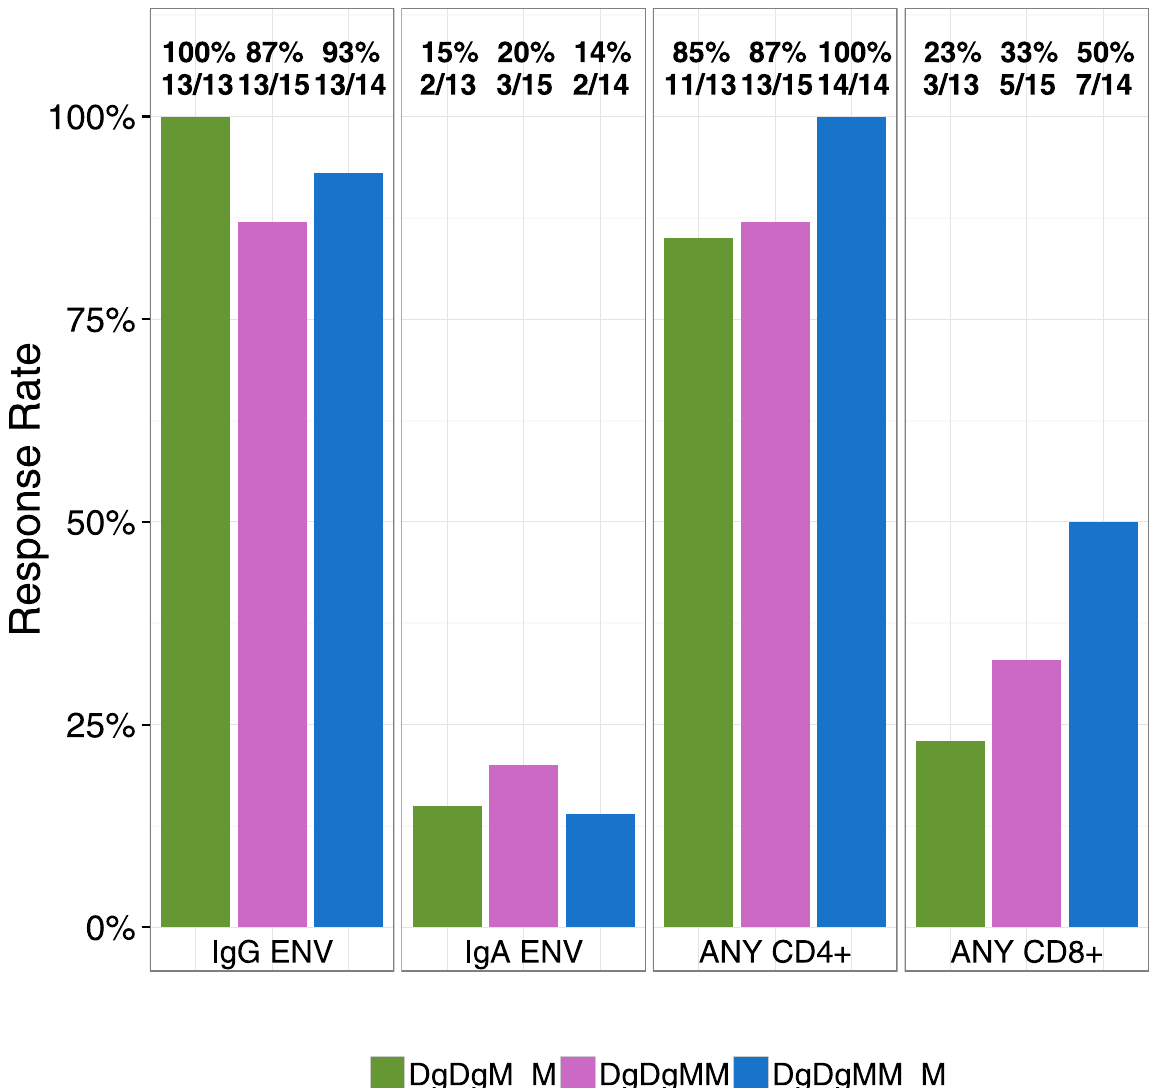
Fig 2. Summary immune responses. Overall peak bindingantibody and ICS response rates among vaccine recipients at two weeks after the 2nd and 3rd MVA in the DgDgM_Mand DgDgMM_Mgroups. DgDgM_Mrefers to immune responses after the last MVA in the DgDgM_Mgroup; DgDgMM and DgDgMM_M refer to immune responses after the 2nd and 3rd MVA in DgDgMM_M group, respectively. A positive responseto IgG Env or IgA Env indicatespositive responses to at least one ENV antigens measured by the BAMA bindingantibodyassay; a positive responseto ANY CD4+ or ANY CD8+ indicatespositive responses to any least one peptidepool and/or cytokine measuredby the ICS assay.